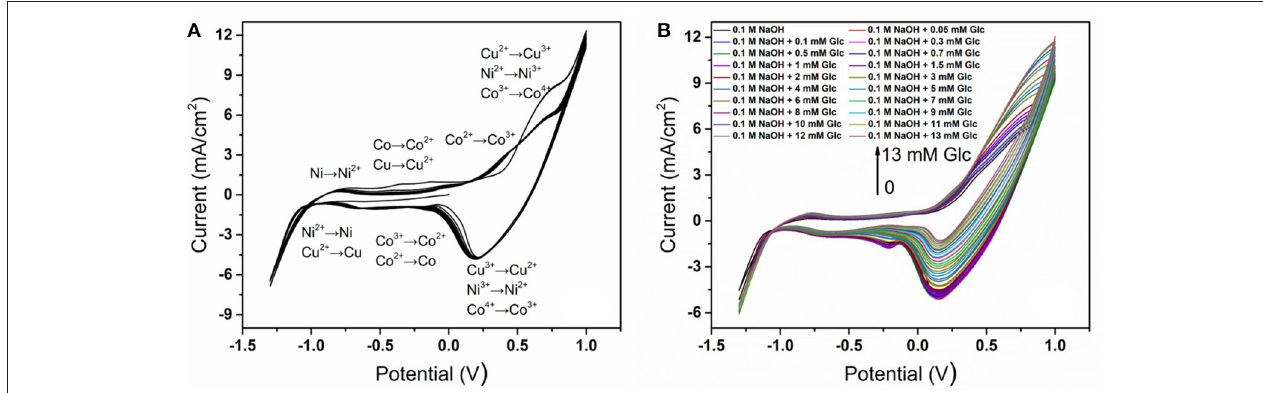
FIGURE 4 | (A) Activated CoNiCu electrode in 0.1M NaOH by CV for multiple cycles; (B) CVs of activated CoNiCu electrode in 0.1M NaOH + different glucose concentrations.